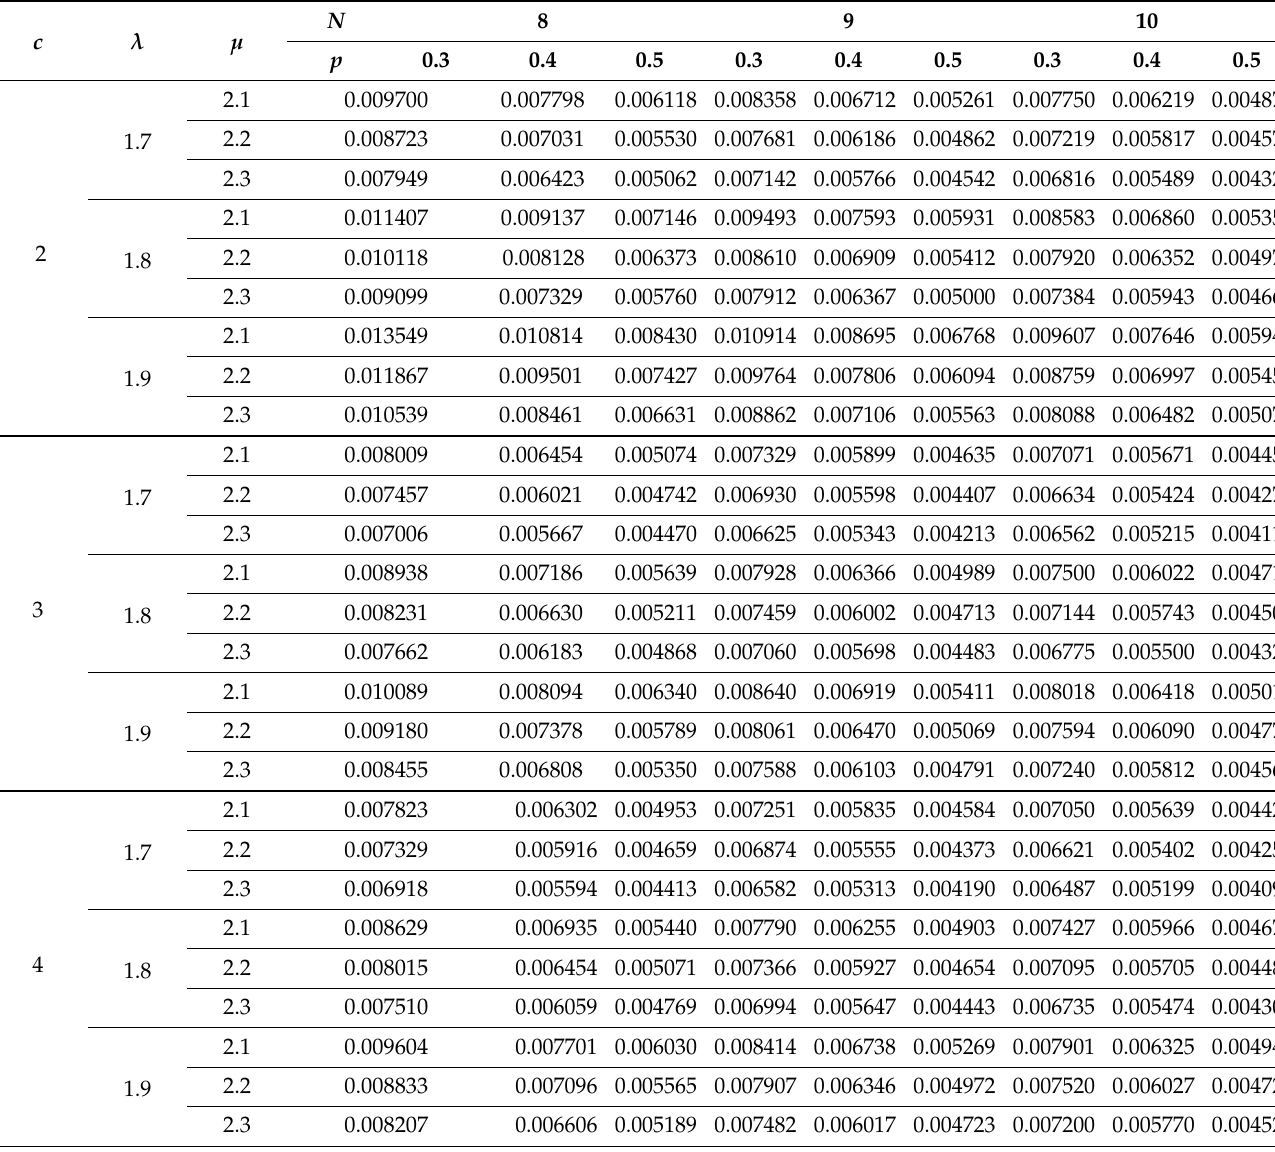
Table 7. Effect of system parameters on the mean number of customers lost ( Λ 5 )